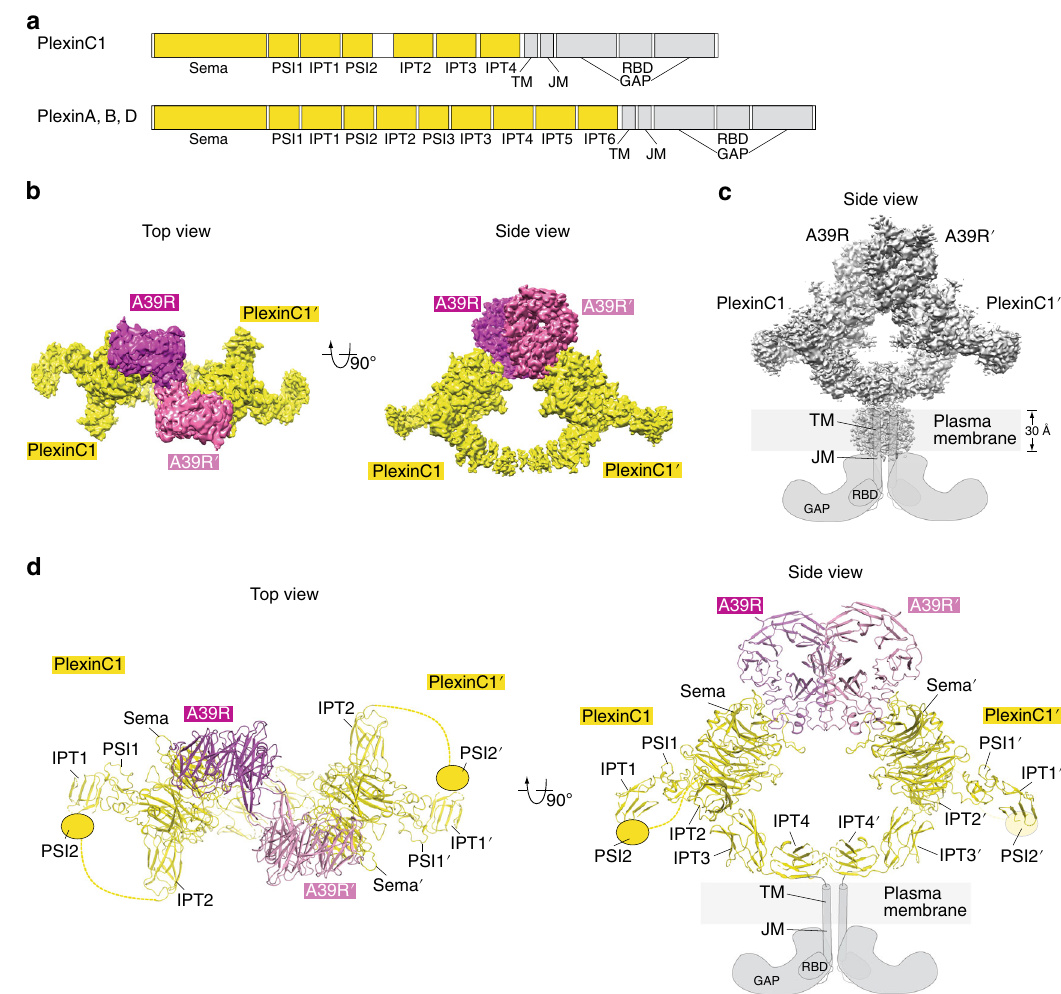
Fig. 1 Overall structure of the full-length PlexinC1/A39R complex. a Domain structures of plexins of different classes. IPT Ig-plexin-transcription factor domain, PSI plexin – semaphorin – integrin domain, TM transmembrane region, JM juxtamembrane region, GAP GTPase activating protein domain, RBD RhoGTPase-binding domain. b Cryo-EM maps of the full-length PlexinC1/A39R complex in two orthogonal views. Detailed maps of various parts of the